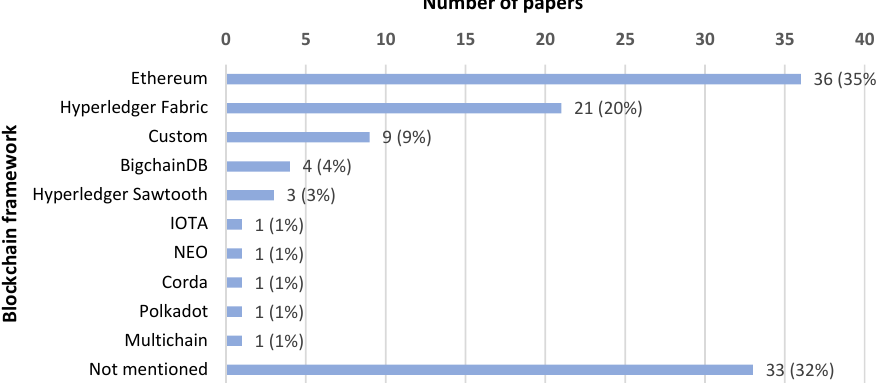
Figure 9. Blockchain technology frameworks considered in the papers included in our scoping